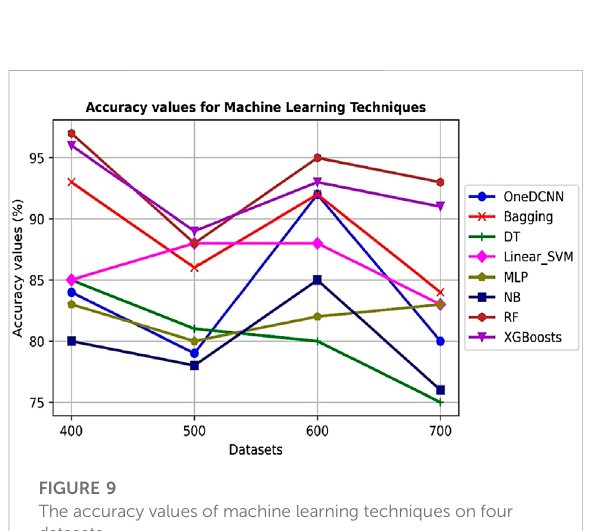
FIGURE 9 The accuracy values of machine learning techniques on four